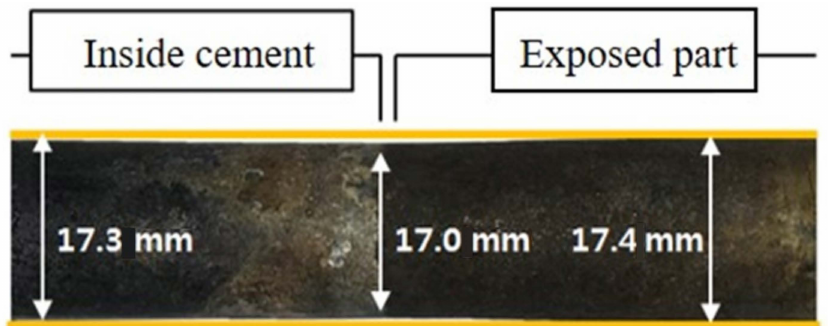
Figure 5. Pin position where crevice corrosion